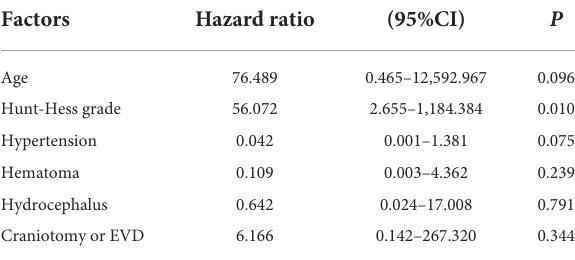
TABLE 2 Multivariable proportional hazards model analysis for poor outcomes at